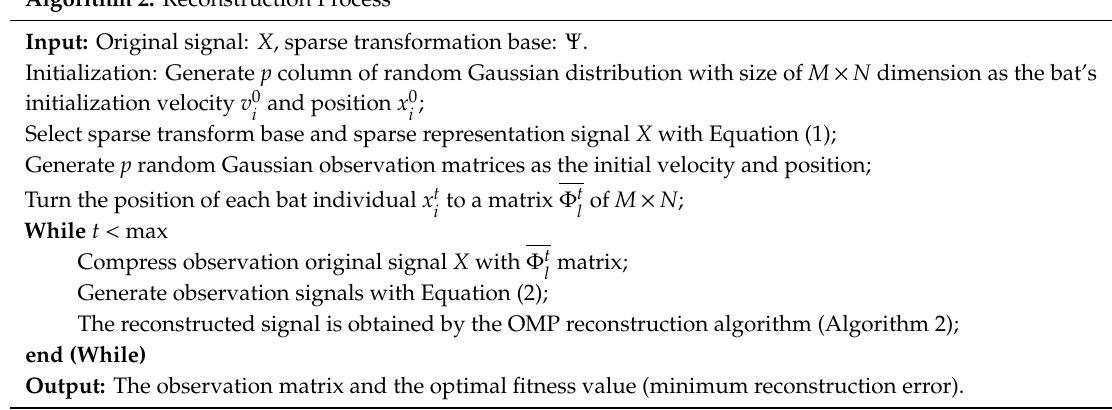
Algorithm 2: Reconstruction